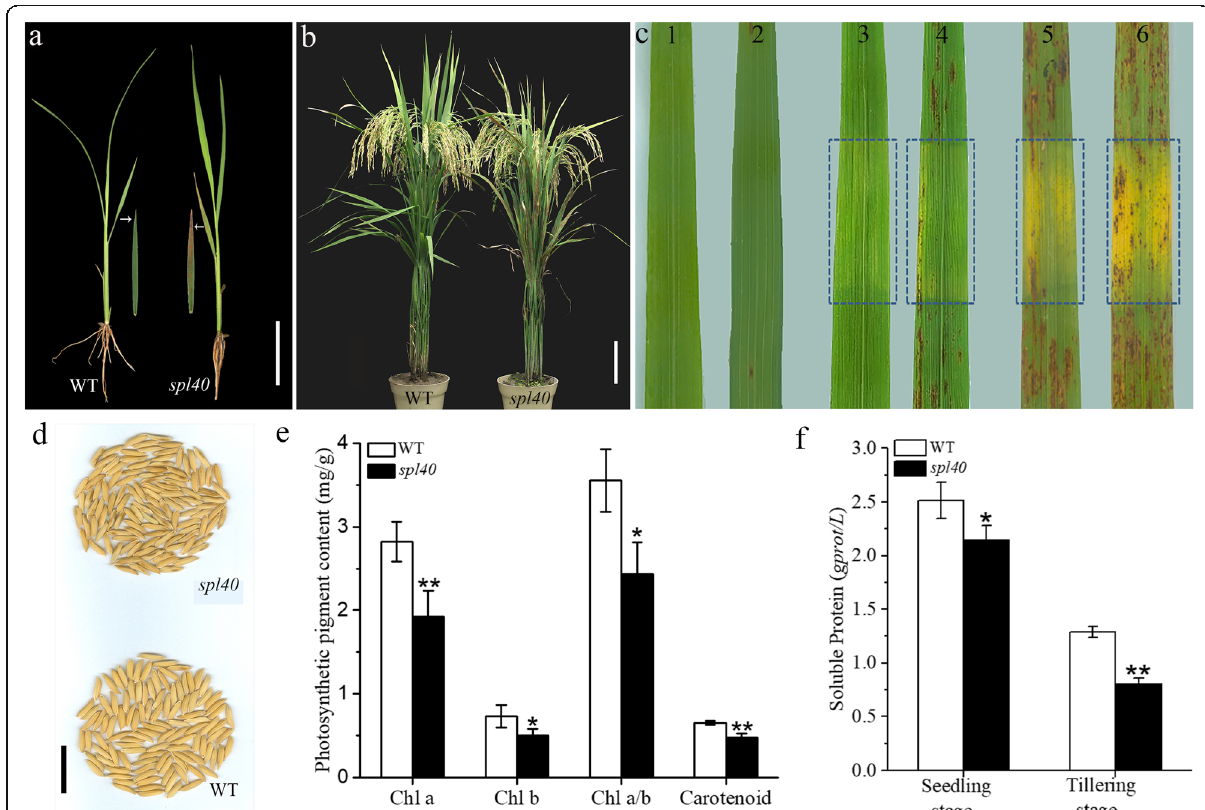
Fig. 1 Spotted leaf phenotype of spl40 . a Lesions appear at 4-leaf stage (shown detached 3rd leaf with lesions) (bar = 5 cm). b WT and spl40 at maturity stage (Scale bar = 10 cm). c Effect of light on lesion formation under the natural condition (1 – 2) Zhongjian100 and spl40 before shading. (2 – 3) Zhongjian100 and spl40 shaded for 7 days. (5) spl40 re-instated for 5 d. (6) spl40 re-instated for 15 d. Shaded areas are boxed. d Lesion phenotype on matured seeds (bar = 2 cm). e Photosynthetic pigment contents at tillering stage. f Soluble protein content at seedling